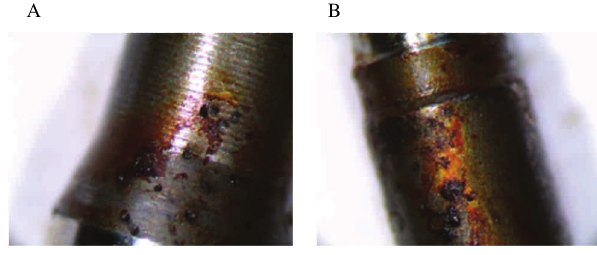
Fig. 10. A – elements of electromagnetic system valve, B – elements of electromagnetic system plate